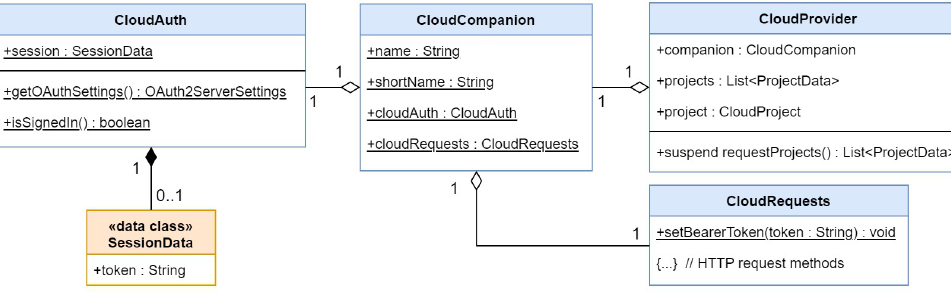
Figure 9. Authentication Mechanism class